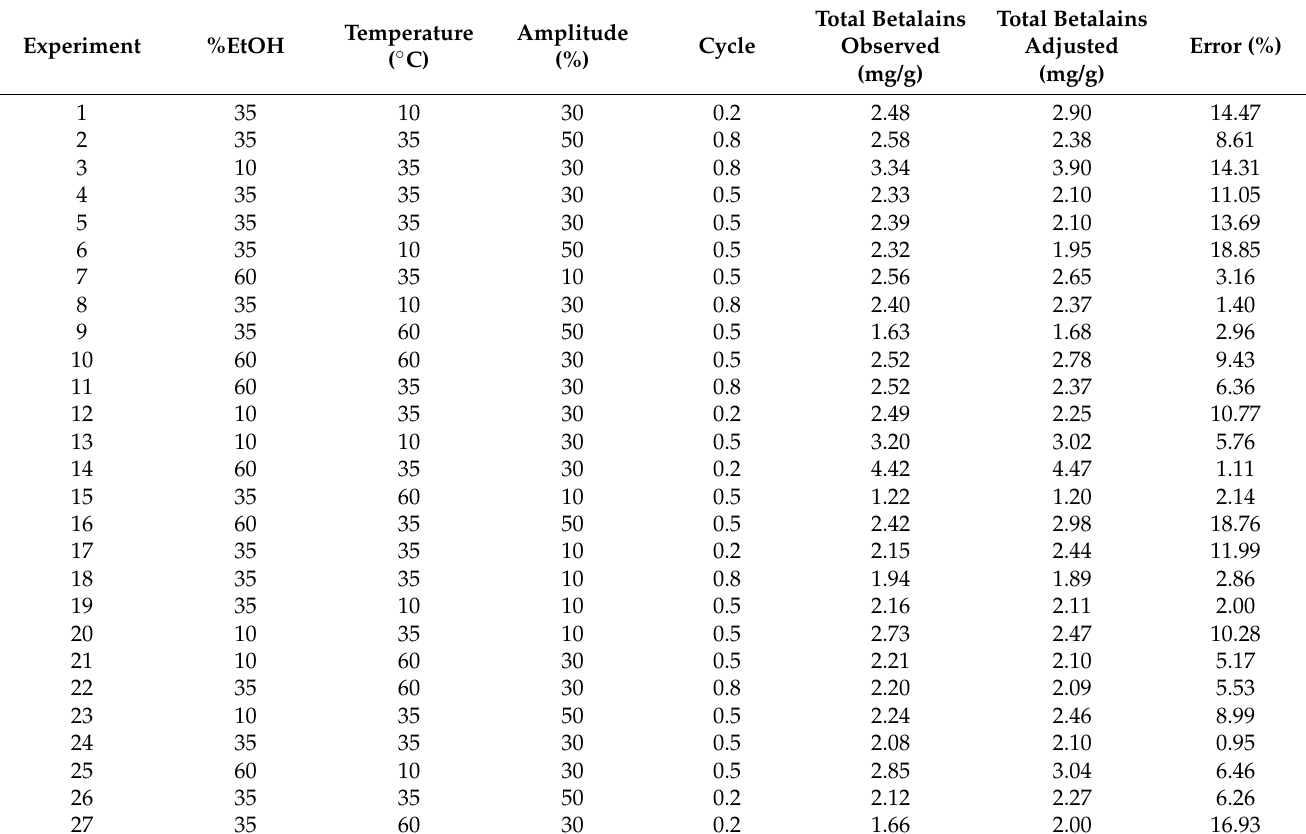
Table 1. Box–Behnken design obtained from the experiments completed to optimize the procedure to extract betalains from Opuntia dillenii